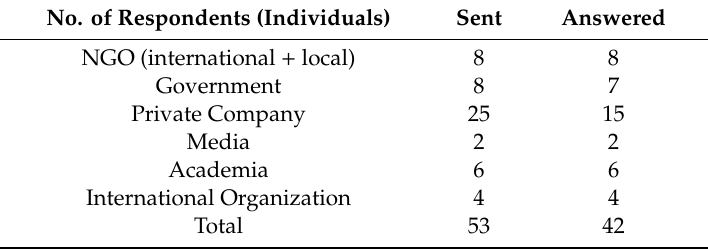
Table 3. Details of the questionnaire